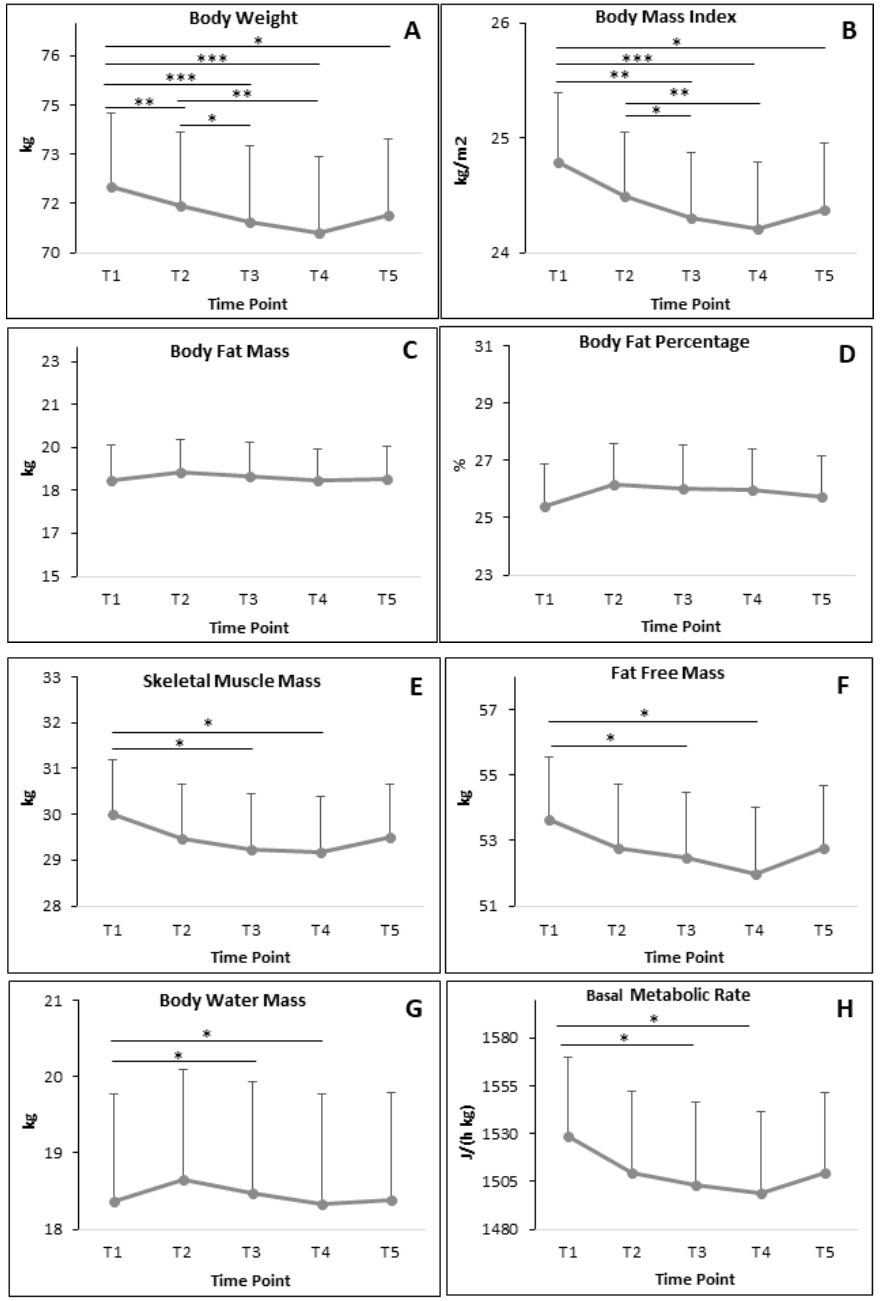
Figure 5. The alteration of BC parameters during RF in all participants ( A : body weight; B : body mass index; C : body fat mass; D : body fat percentage; E : skeletal muscle mass; F : fat free mass; G : body water mass; H : basal metabolic rate). Data presented in mean and SEM. * p < 0.05; ** p < 0.01; *** p < 0.001.